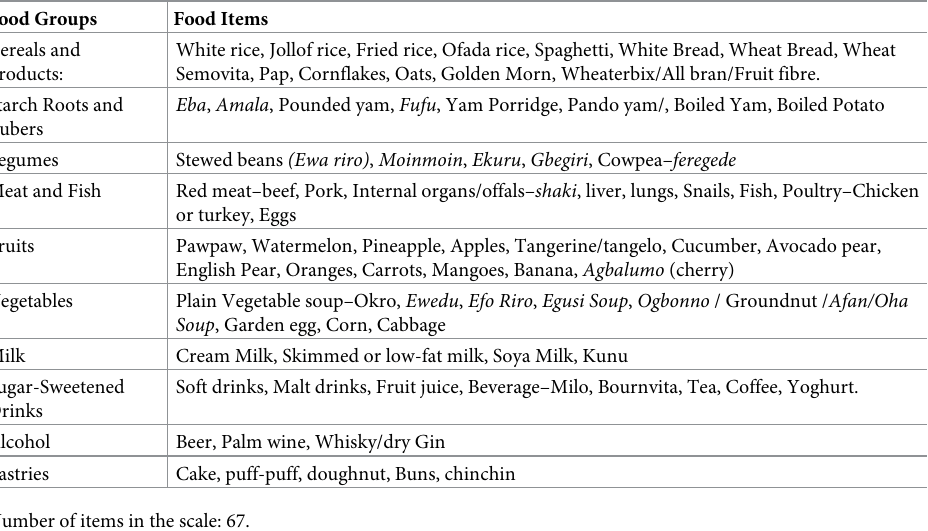
Table 1. Food items and food groups used in the dietary patterns. Food Groups Food Items Cereals and